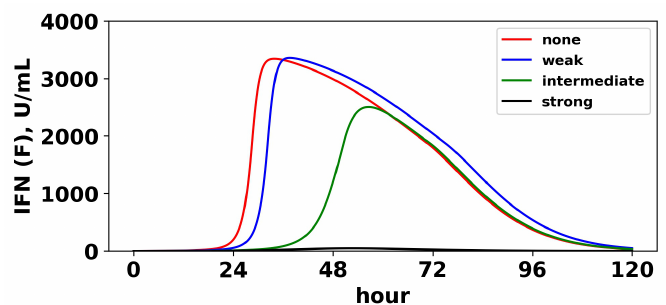
Figure 12. Viral antagonism of IFN induction delays activation of the feedback loop. Extracellular IFN levels ( F ) are shown for four levels of IFN induction antagonism. For all levels, we set p = 0.3, and we assumed a pulsed secretion rate model with q 0 = 0.1 and q 1 = 1. As the level of antagonism is increased, activation of the feedback loop is delayed, and in the case of strong antagonism, the feedback loop is blocked. The delay or blockage of activation leads to the loss of protection, as shown in Figure 11.